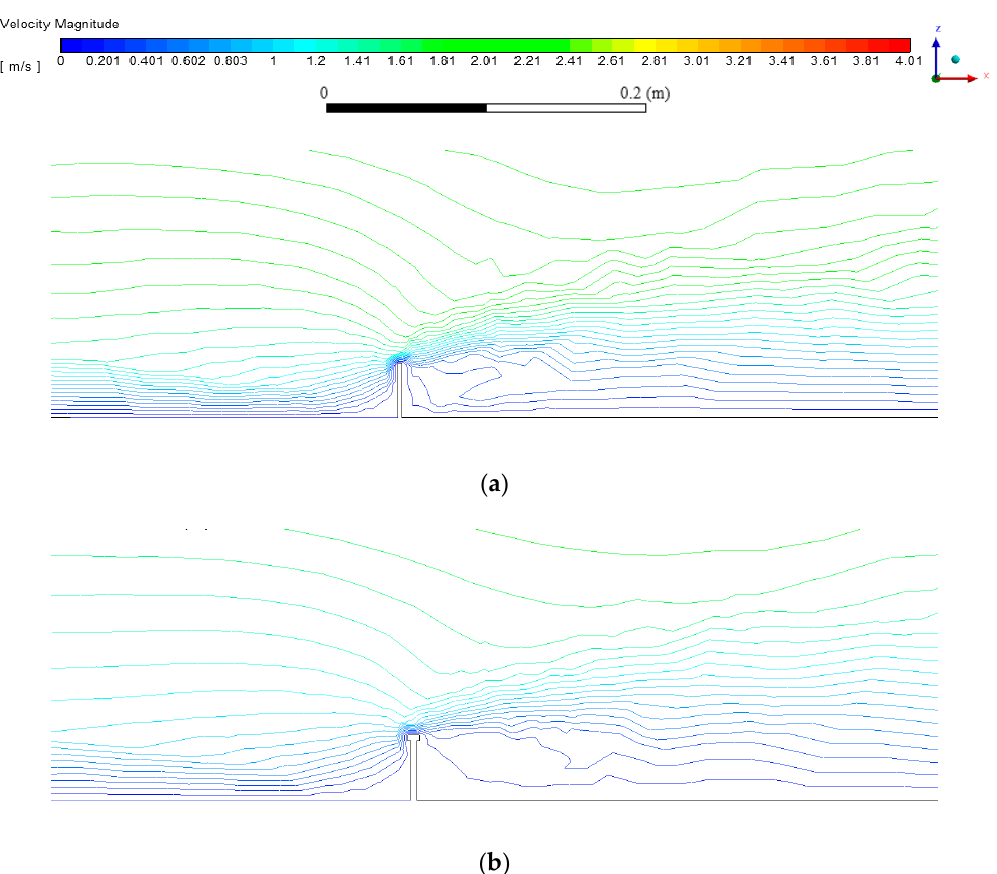
Figure 15. Contours of CO molar concentration for different barrier shapes (H = 6 m). ( a ) Base case; ( b ) case 1; ( c ) case 2; ( d ) case 3; ( e ) case 4.